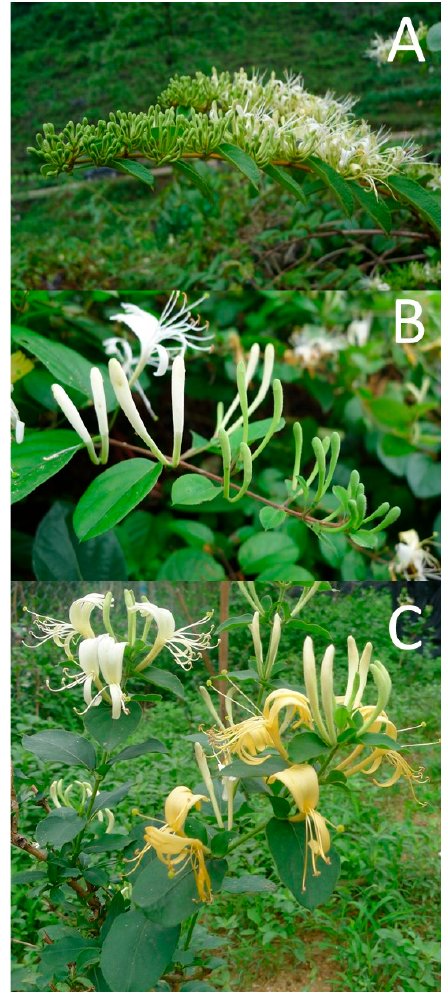
Fig 1: The flowers and leaves of (A) L. fulvotomentosa, (B) L. hypoglauca and (C) L.